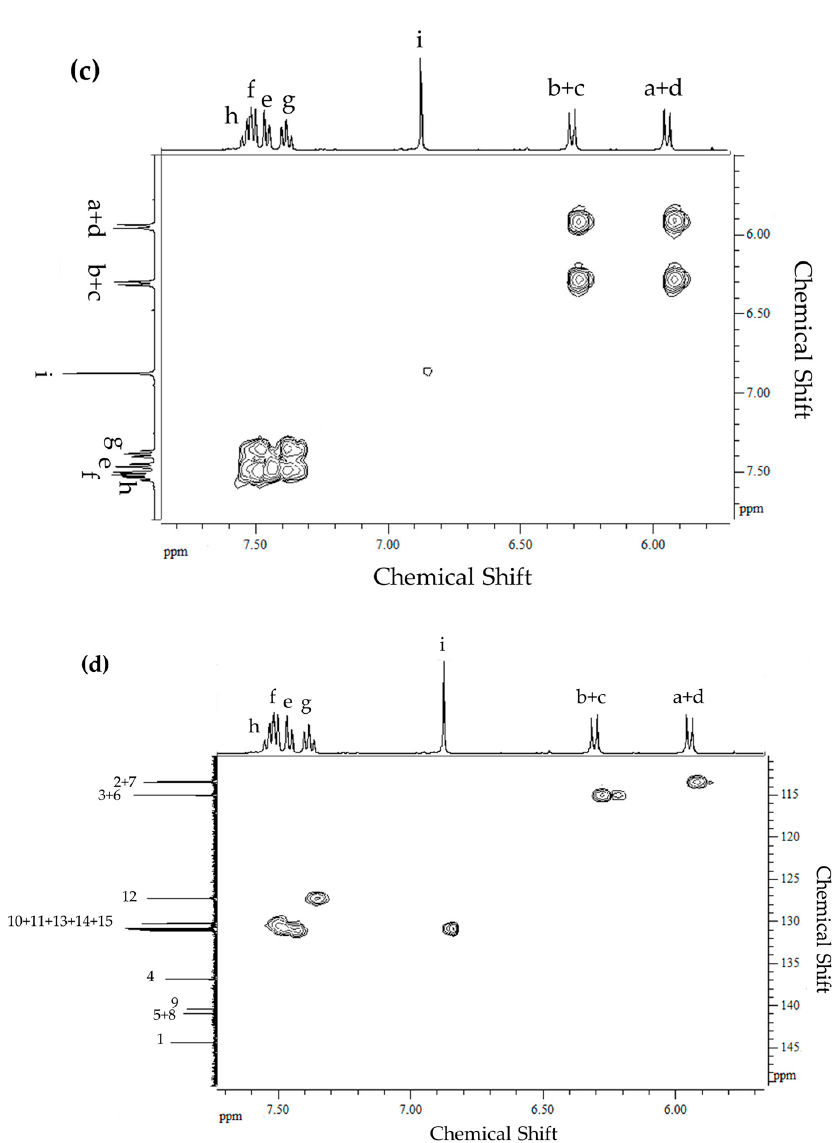
Figure 1. ( a ) 1 H–NMR; ( b ) 13 C–NMR; ( c ) H–H COSY; and ( d ) C–H HSQC spectrum of M4 in DMSO- d 6 .